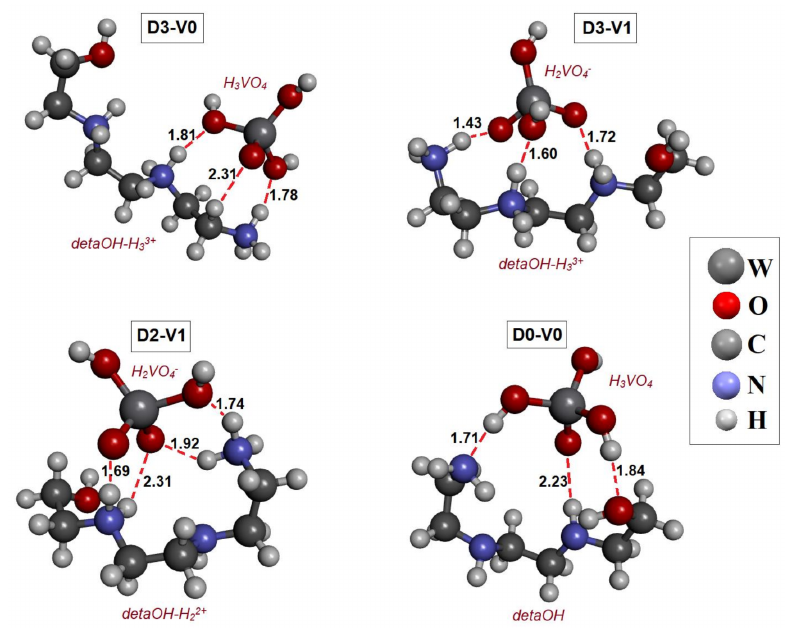
Figure 11. The optimized structures of dimers (bond lengths are given in Å), used to estimate the interaction energies between vanadium (V) oxyanions and detaOH absorbent. D3, D2, D0, V0 and V1 abbreviations in the labels of dimers refer to detaOH-H 33+ , detaOH-H 22+ , detaOH, H 3 VO 4 , and H 2 VO 4 − , respectively. Table 5. The labeling of starting and optimized dimers and calculated energies of interactions (in kcal/mol) between vanadium (V) oxyanions and detaOH absorbent. Starting Optimized Abbreviation Interaction Geometry Geometry of Dimer Energy detaOH-H 33+ ... H 3 VO 4 detaOH-H 33+ ... H 3 VO 4 detaOH-H 33+ ... H 2 VO 4